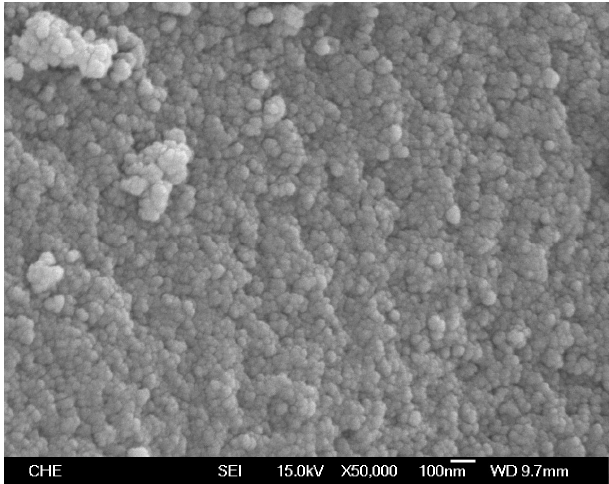
Figure 2. Scanning electron micrograph of Re-Ru@SiO 2 particles with a Ru/Si atomic ratio of 0.4.